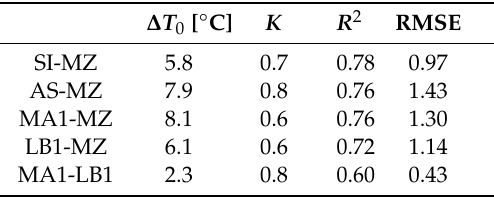
Table 2. Fit characteristics and likelihood parameters (coe ffi cient of determination R 2 and root mean square error RMSE) between data in Figure 6b and Equation (2) for the di ff erent